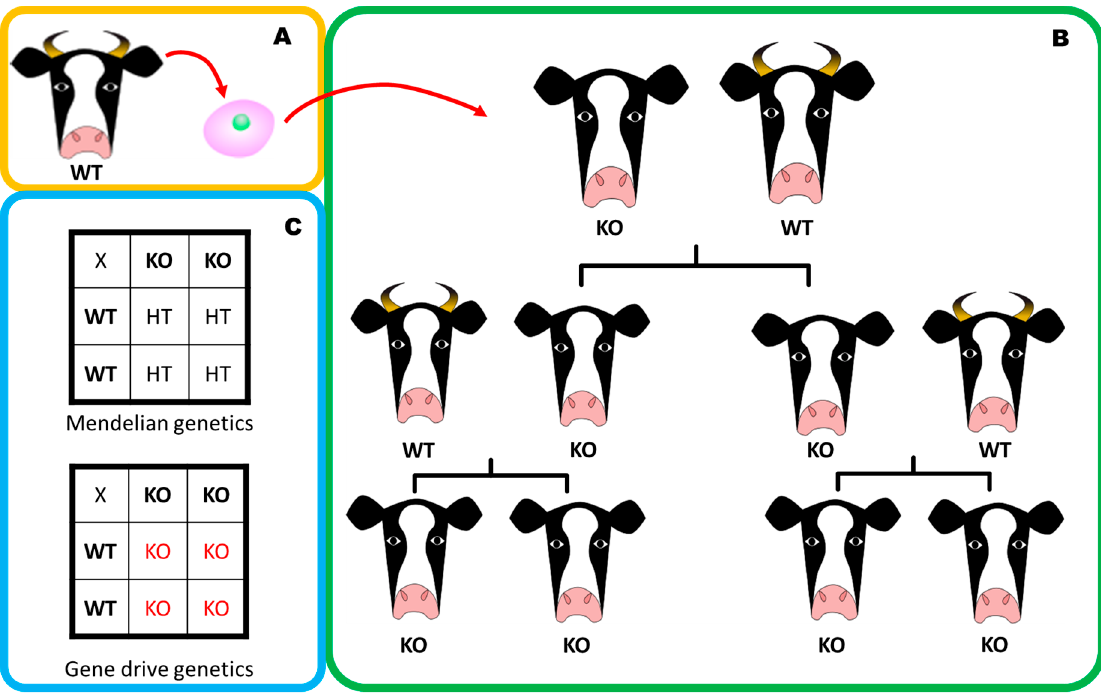
Figure 2. ( A ) The genome of an ideal milking Holstein is modified with a gene drive targeting the polled gene (responsible for horns in cattle) resulting in a polled gene-drive knockout cell line. ( B ) Somatic cell transfer produces knockout progeny which are raised and bred with the best milkers (wt for the polled gene), the gene drive ensures the breeding program yields exclusively knockout/hornless progeny. ( C ) Punnett squares demonstrate non-Mendelian genetics of gene drives and all heterozygous offspring in a conventional breeding setting become homozygous knockouts at the polled locus. Figure adapted from Gonen et al. [105].